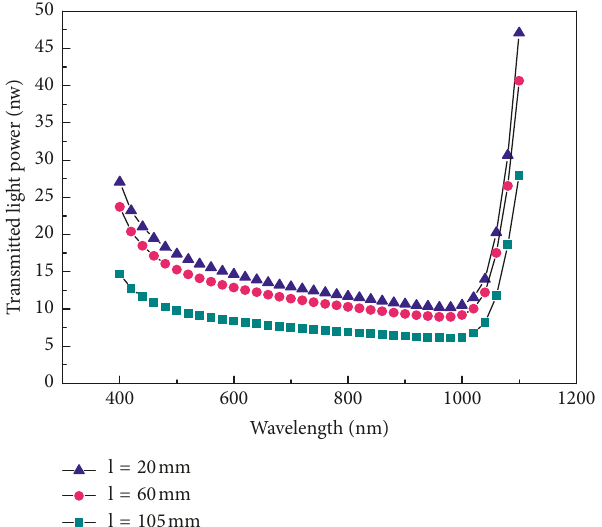
Figure 19: Effect of the specimen length on the light